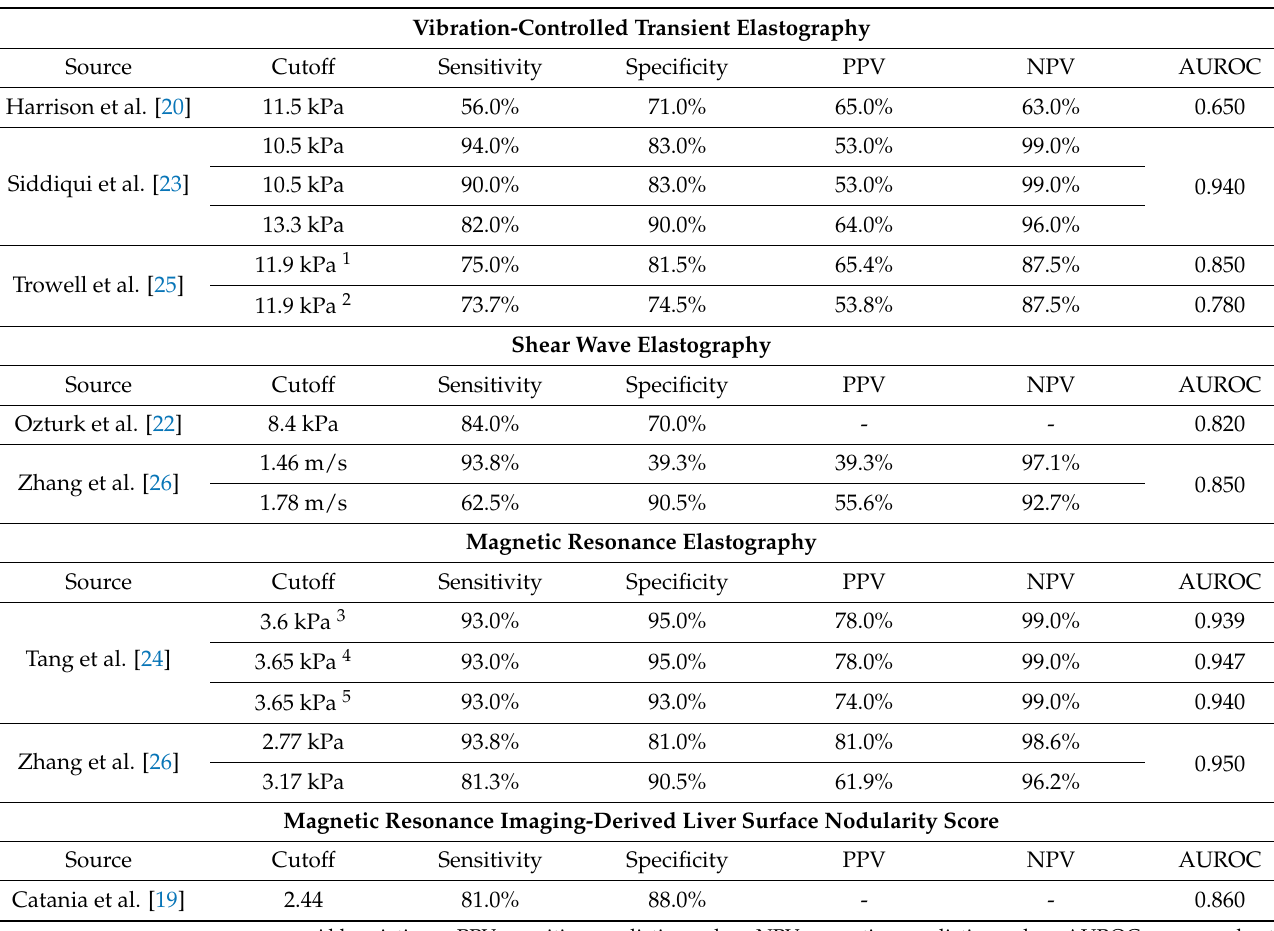
Table 5. Diagnostic accuracy of imaging techniques for advanced